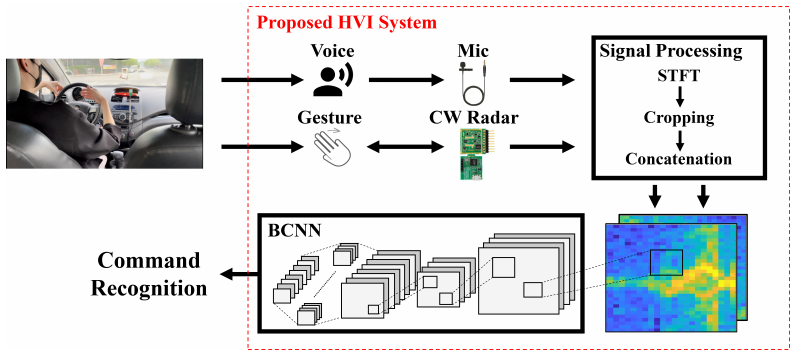
Figure 1. Overview of the proposed